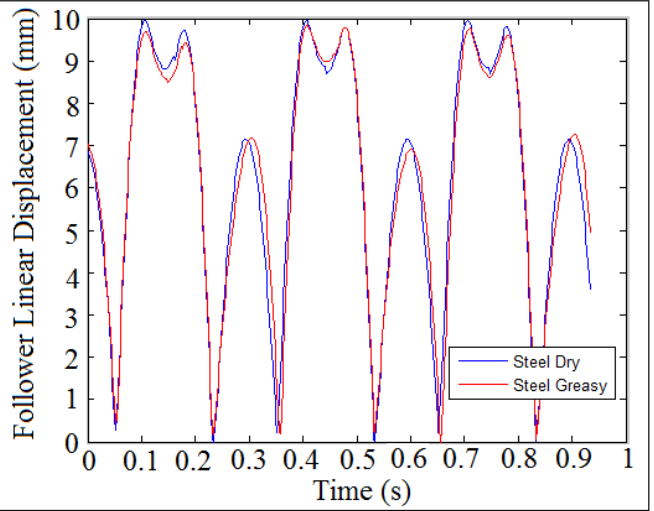
Figure 46. Follower linear displacement against time at (I.D. = 19 mm) and (N = 200 rpm) using different types of contacts.